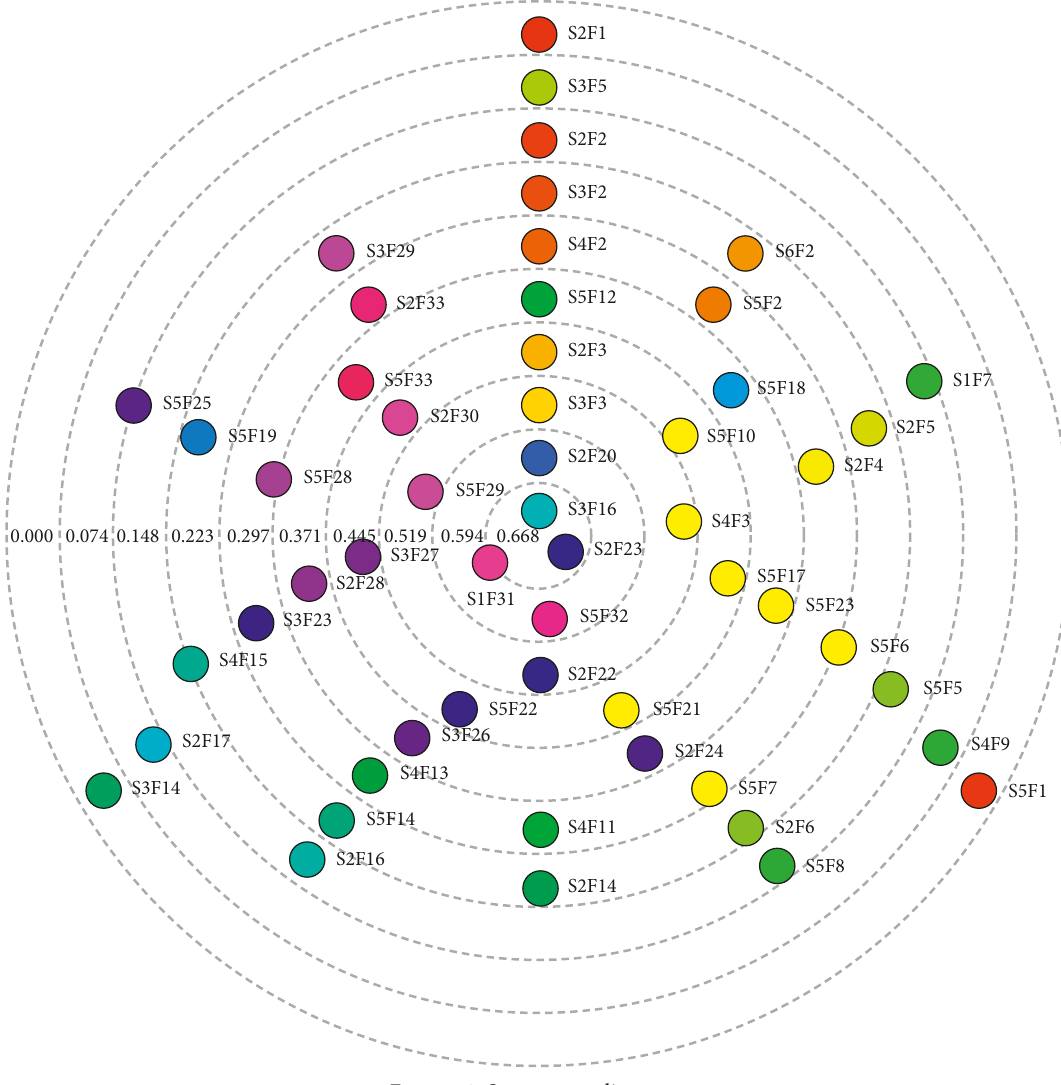
Figure 4: Status centrality map. Table 2: Critical factors based on degree analysis, ego network, and status